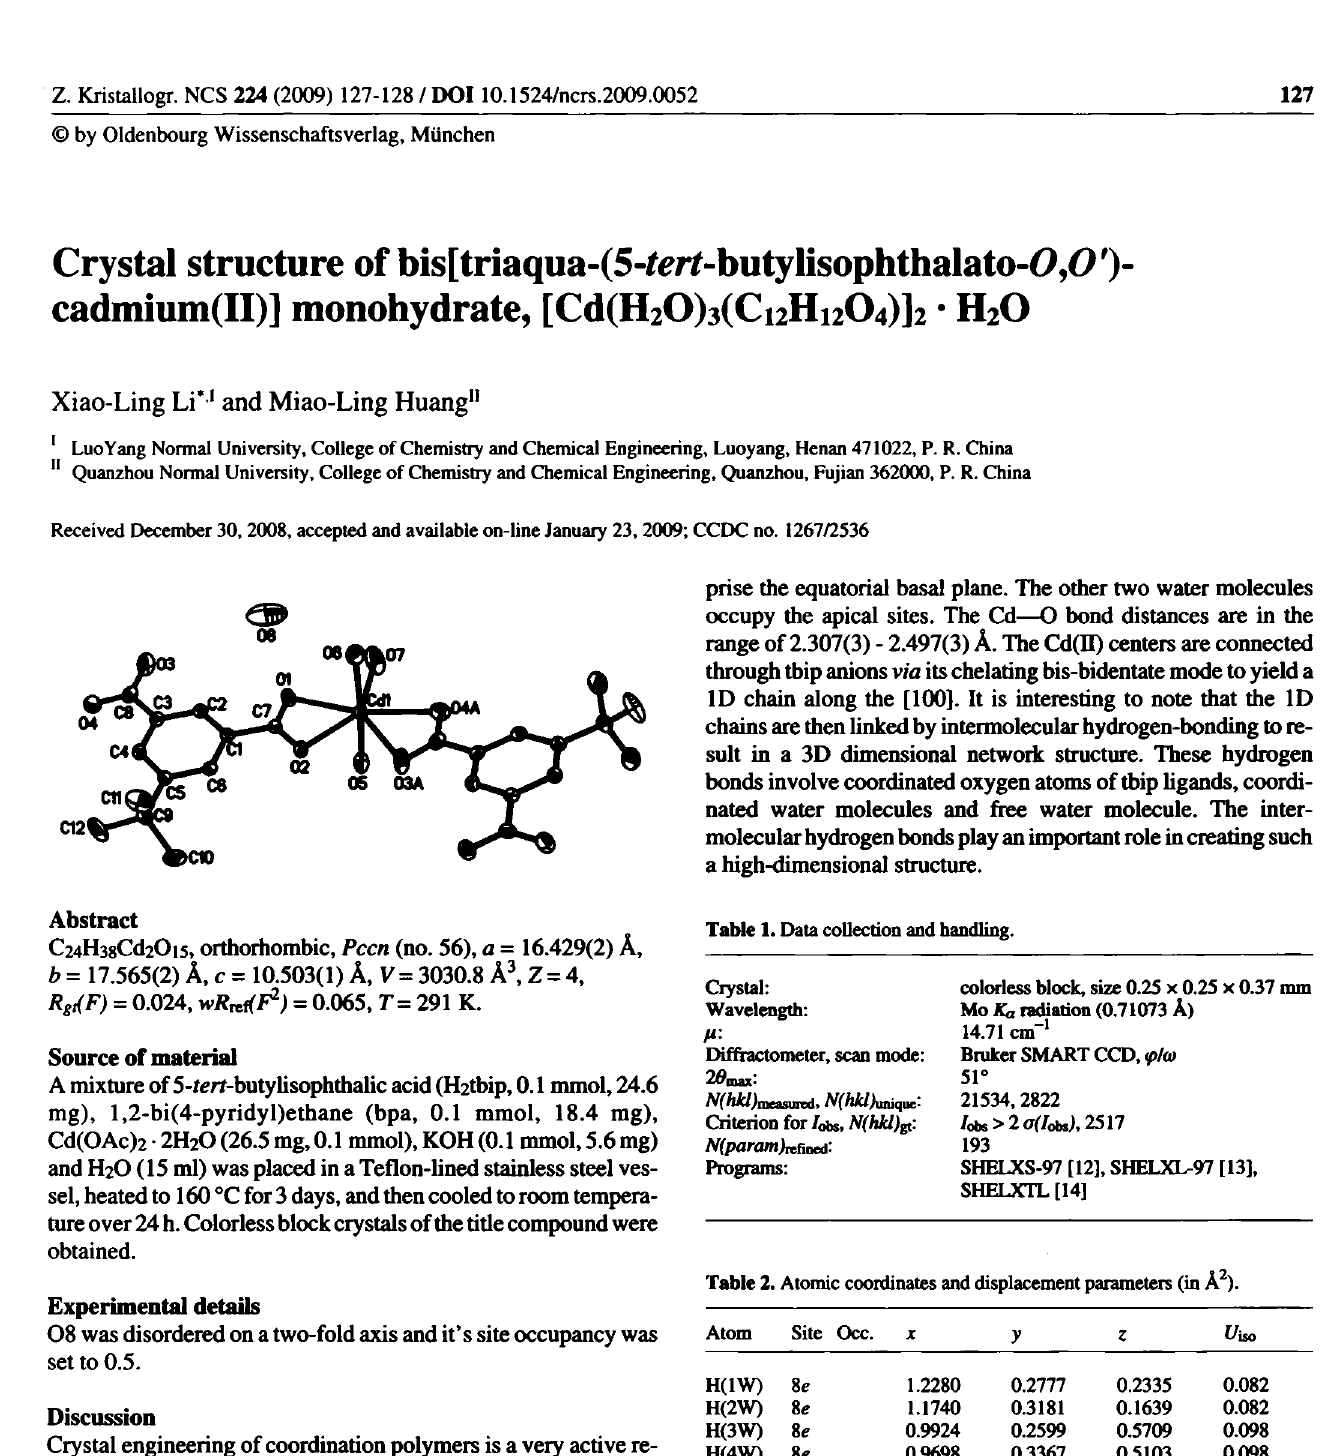
Table 2. Atomic coordinates and displacement parameters (in Â 2